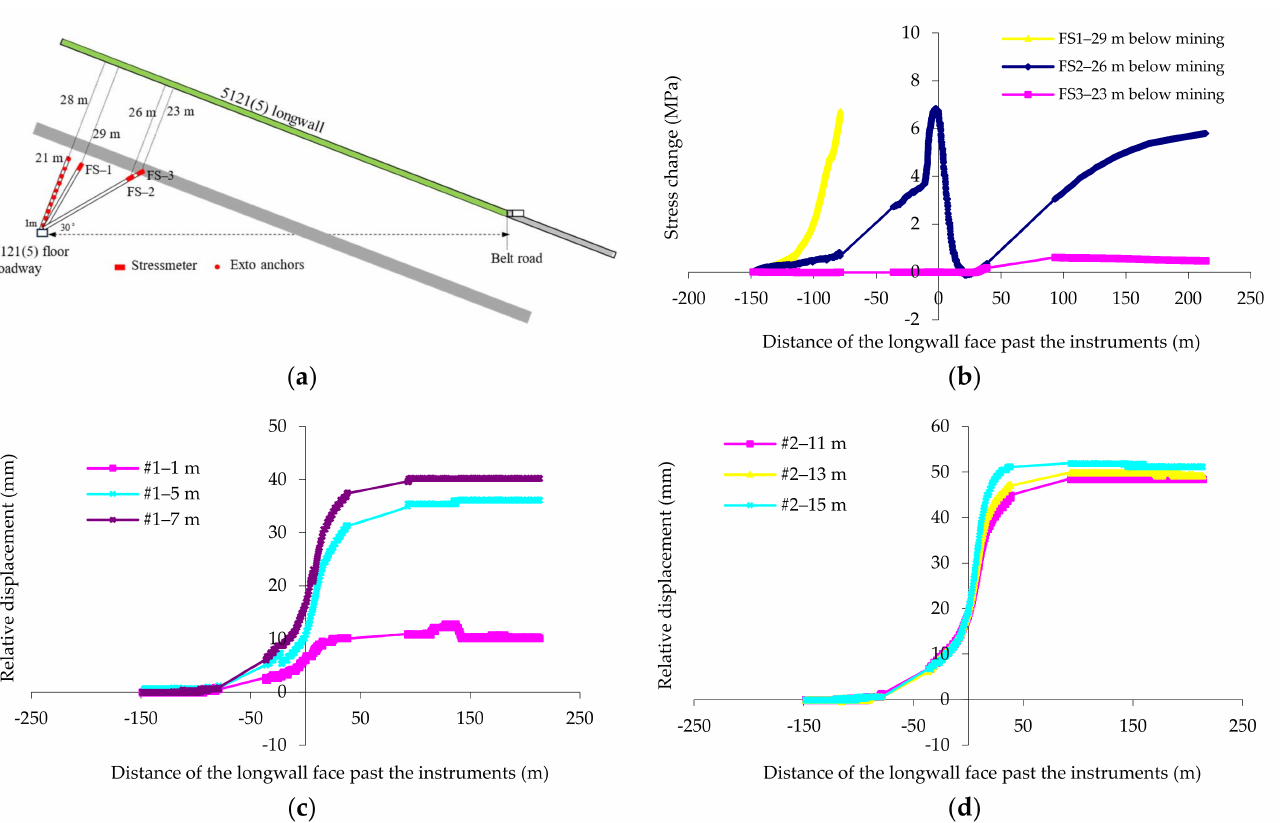
Figure 5. The key results from the − 780 m C13 floor roadway: ( a ) location of the instruments; ( b ) mon- itored stress changes in the floor strata; ( c ) monitored strata deformation by #1 extensometer (#1–1 m denotes the anchor was located 1 m from the borehole collar); ( d ) monitored strata deformation by #2